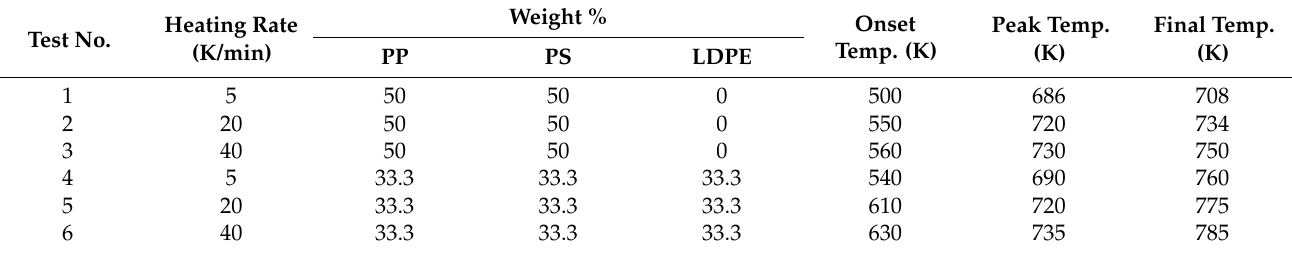
Figure 2. Thermogravimetric (TG) curves of equi-mass ternary mixtures of PP, PS, and LDPE (Tests 4–6). Inset: corresponding derivative thermogravimetric (DTG) curves. Table 4. Onset, peak, and final decomposition